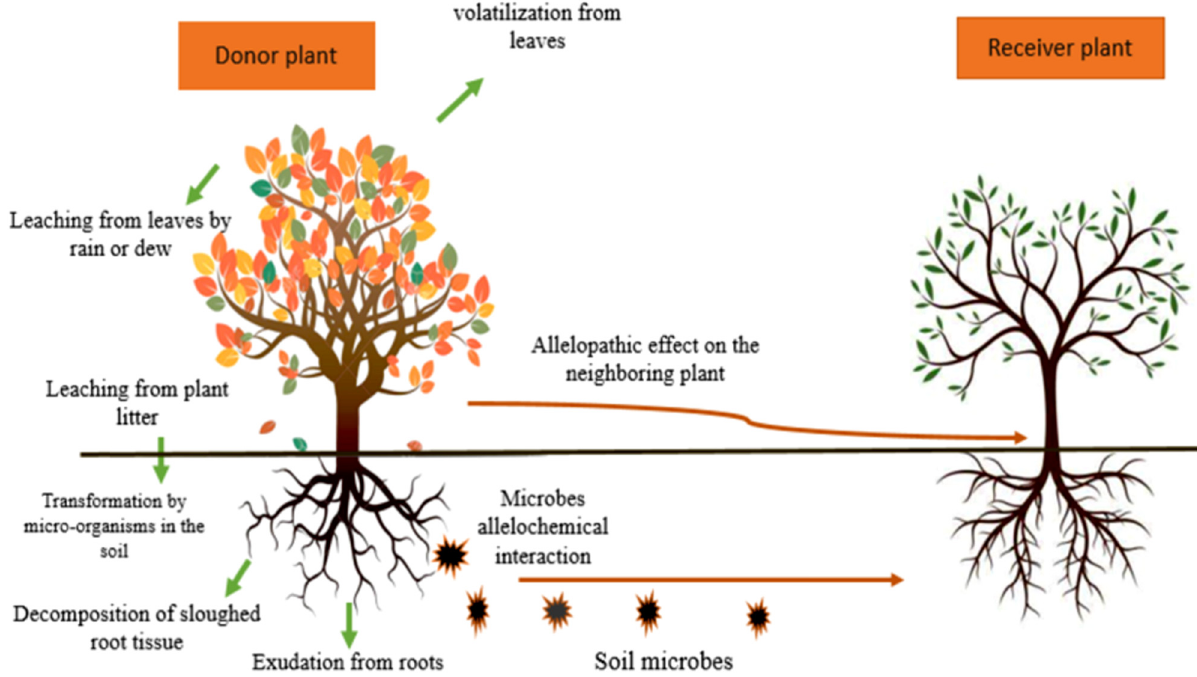
Figure 1: Routes for the release of allelochemicals, elicitation by microbes, and its e ff ect on other